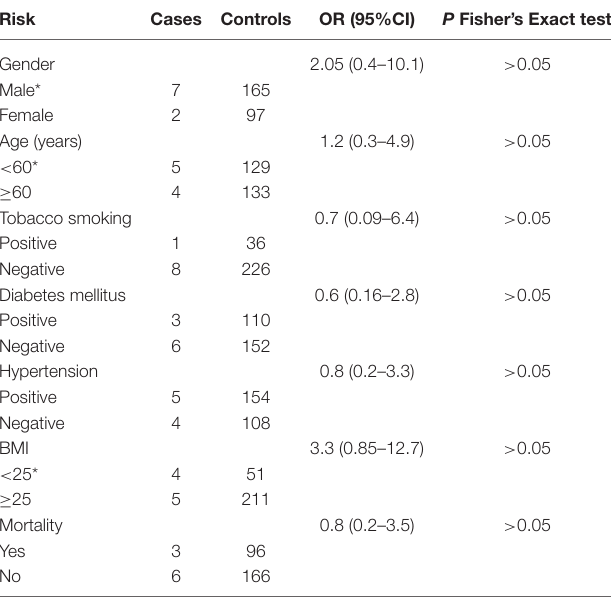
TABLE 6 | Odds ratios obtained from contingency tables